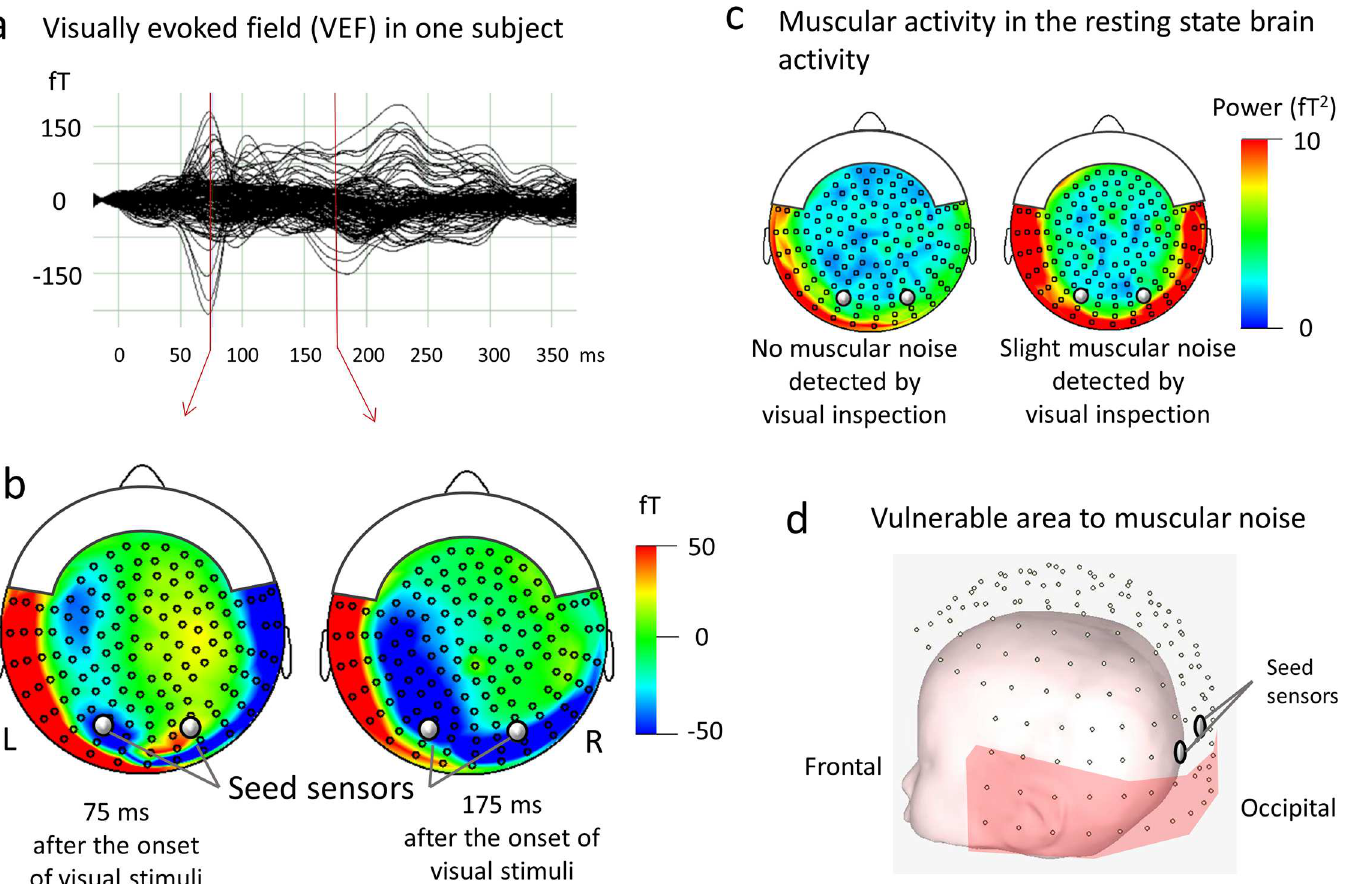
Fig 2. Seed sensors for highsignalsfrom visualcorticesand low noisefrom muscularactivity. (a) A representative example of the magnetic responses to the visual stimuli obtainedfromone subject(8-year-oldboy). MEG waveforms(147 channels)are overlaid at the correctedbaseline. (b) Isocontour maps of the magneticfield afterpatternreversal visual stimuli.The magneticfield strengthis indicatedby color, varyingfromblue (flux-in)to red (flux-out))at the responsepeak 75 and 175 msec afterpatternreversal. Two seed sensors are indicated by gray circles and the other146 sensorsare indicatedby dots. In two seed sensors, signals fromvisual cortices(i.e., visually evoked response)were optimallyrecorded. (c) Contamination of muscular activityin restingstatebrain activity. Topography of gammaband (30–58Hz) power duringrest with (right)and without(left)visually confirmed muscle activity. Sensorslocatedin the ventral area (right)are vulnerable to muscular noise. (d) Vulnerable areas to muscularnoise are close to the muscles of head and neck (e.g. temporalmuscles). Two seed sensors indicated by gray circles are locatedoutsideof these vulnerable areas to muscular noise.